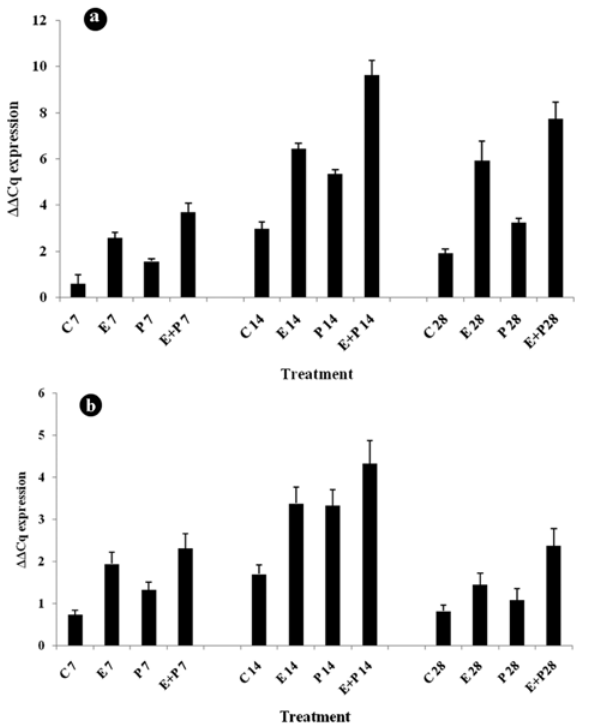
Figure 2. The relative gene expression of chitinase (a) and defensin(b) in sunflower plants inoculated with Fusarium solani and/or treated with turmeric extract at 7, 14 and 28 d after inoculation, using qRT-PCR. C = control, E = extract- treated, P = F. solani inoculated, and E+P = extract-treated +